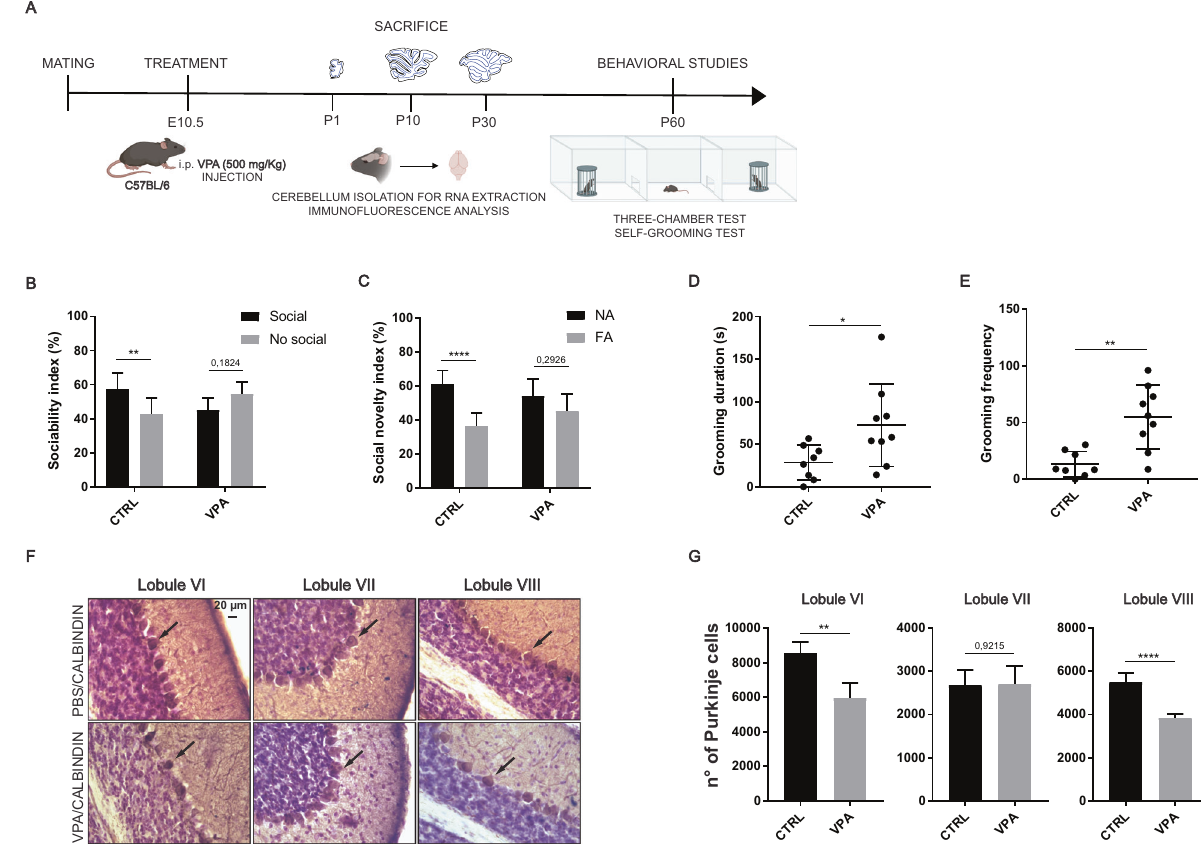
Fig. 3 Behavioural and morphological alterations in the VPA-treated mice. A Experimental design used to develop the VPA model of ASD. B Sociability index in male Ctrl ( n = 8) and VPA ( n = 9) mice measured by the percentage of time spent in close interaction with the animal or the object over the sum of the two interactions. C Social novelty index in male Ctrl ( n = 8) and VPA ( n = 9) mice measured by the percentage of time spent in close interaction with the familiar animal (FA) or a novel animal (NA). Data are expressed as: mean ± SD, * p value ≤ 0.05; ** p value ≤ 0.01; *** p value ≤ 0.001; **** p value ≤ 0.0001; number = not signi fi cant, statistical test = two-way ANOVATukey ’ s multiple comparisons. D Grooming duration in male Ctrl ( n = 8) and VPA ( n = 9) mice measured by the total time (seconds) spent in grooming. E Grooming frequency in male Ctrl ( n = 8) and VPA ( n = 9) mice measuring the number of times mice had grooming. Data are expressed as: mean ± SD, * p value ≤ 0.05; ** p value ≤ 0.01; *** p value ≤ 0.001; **** p value ≤ 0.0001; number = not signi fi cant, statistical test = unpaired t test. F Calbindin immunostaining of Ctrl and VPA mice cerebella (Lobules VI, VII, and VIII) at P30. Black arrows indicate the PCs. G Quantitative analysis of the number of PCs in the indicated cerebellar lobules as determined by stereotaxic analysis. Data are expressed as: mean ± SD, * p value ≤ 0.05; ** p value ≤ 0.01; **** p value ≤ 0.0001; number = not signi fi cant, test = unpaired t in two studies of post-mortem ASD brains (GSE28521, GSE64018) [19, 37] indicated a signi fi cant overlap (Fig. 2G, H). These analyses indicate that expression of a large subset of genes mutated or differentially expressed in ASD is dynamically regulated during post-natal cerebellar development. Fetal exposure to VPA induces ASD-associated behaviours and cerebellar cortical alterations Exposure to VPA during pregnancy was shown to increase the risk of autism in children [52]. Likewise, rodents exposed to VPA during fetal development display autistic features after birth [6, 13]. Thus, we employed the VPA model to test whether cerebellar expression of ASD-linked genes is dysregulated in mice affected by the disease. Pregnant females were treated with a single peritoneal injection of VPA at embryonic day 10.5 (E10.5), a protocol that was previously shown to alter synaptic transmission in the cerebellar cortex [27, 28]. After birth, cerebella were isolated from control (saline) and VPA-treated mice at P1, P10 and P30 for RNA and protein analysis (Fig. 3A). In parallel, littermate mice were analysed at P60 by behavioural tests related to ASD (Fig. 3A). First, we assessed the performance of VPA-treated mice in the three-chamber sociability test [40]. Analysis of the exploratory